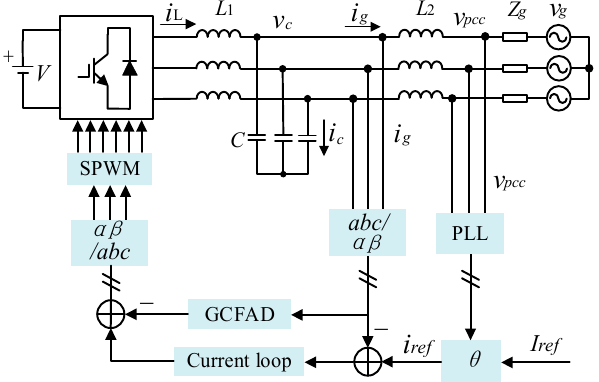
Figure 1. Structure and control scheme of grid ‐ connected LCL inverter.